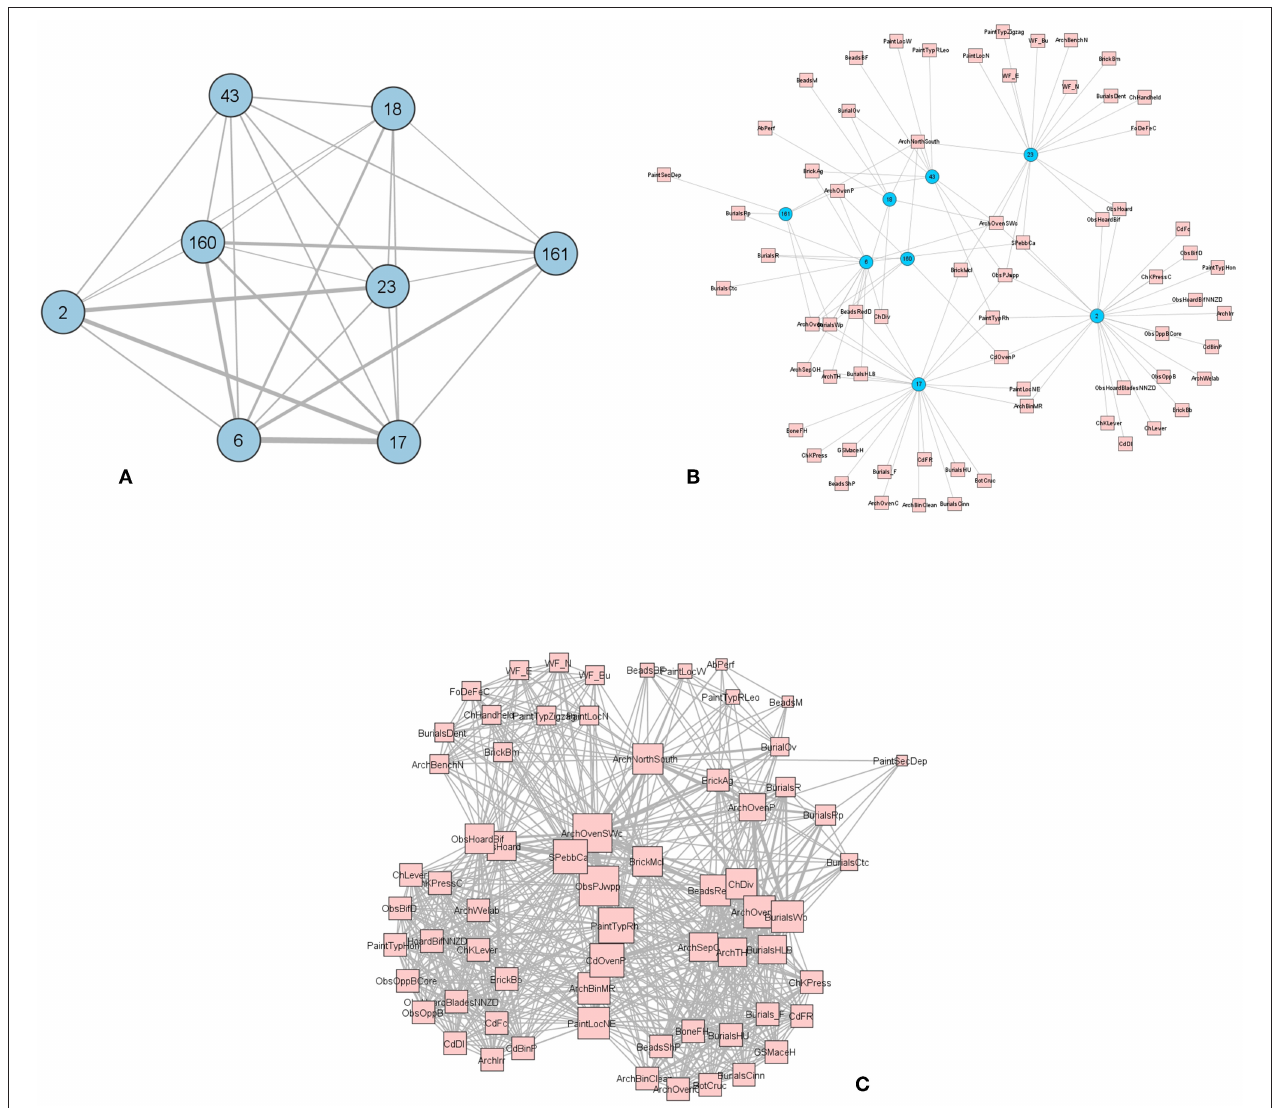
FIGURE 6 | Early network of buildings (A) , 2-mode early network (B), and early network of objects (C) (The codes used are in the Supplementary Material